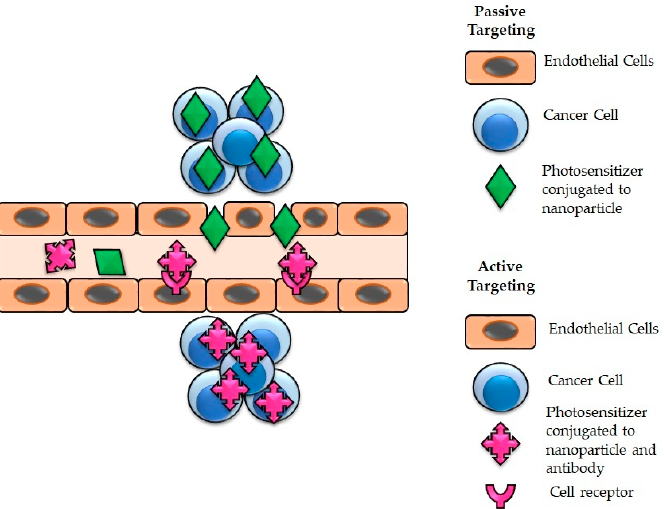
Figure 3. Enhanced cellular accumulation of PDT photosensitizer drugs using passive and active functionalized nanomedicine cancer targeting and delivery mechanisms.